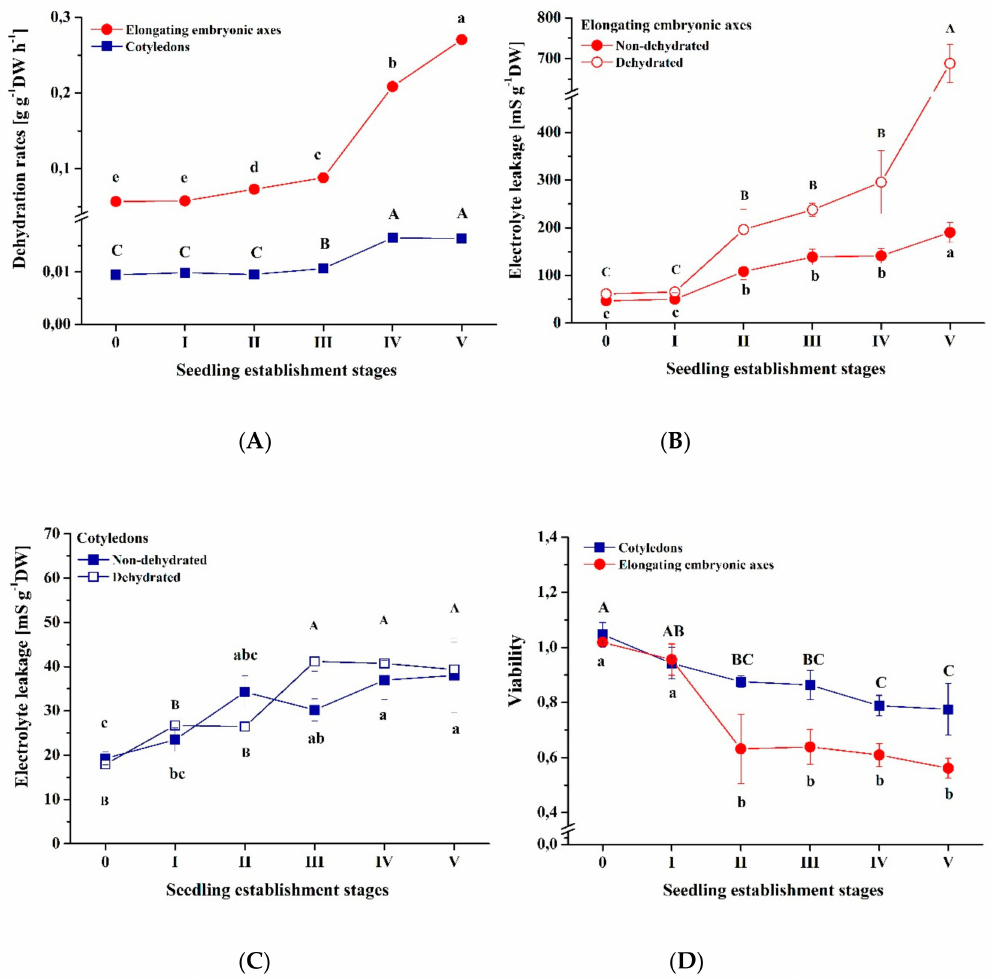
Figure 3. Changes in dehydration rates ( A ), electrolyte leakage before and after dehydration ( B , C ) and viability ( D ) of elongating embryonic axes and cotyledons of Fagus sylvatica reported at early seedling establishment stages. Data are the means of three independent replicates ± the standard deviation. Statistically significant di ff erences are indicated with di ff erent letters (one-way ANOVA followed by Tukey’s test at p ≤